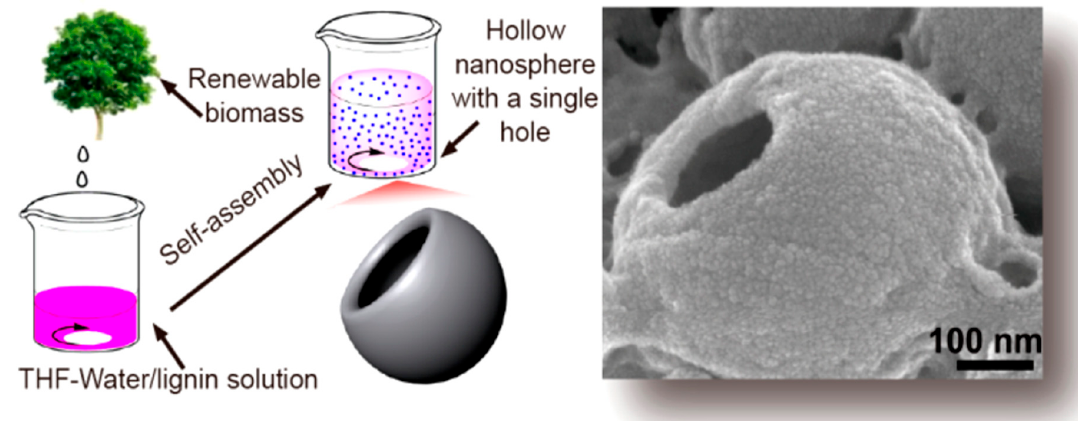
Figure 13. Preparation of renewable lignin hollow nanospheres with a single hole by self-assembly. Reprinted from [117] with permission from American Chemical Society © 2020.